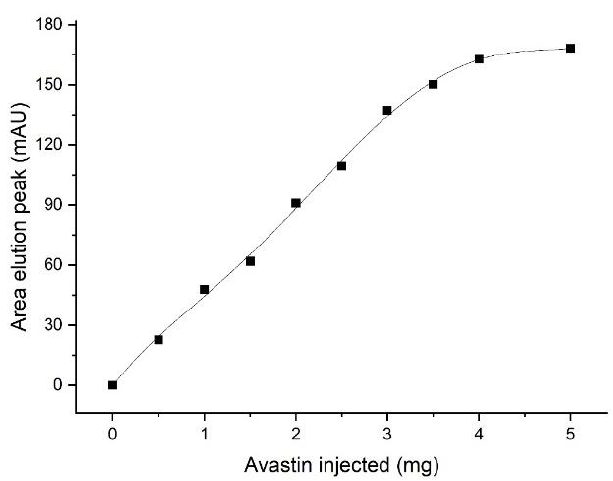
Figure 6. Avastin saturation curve of the VitraPOR 5 monolith coated with protein A.